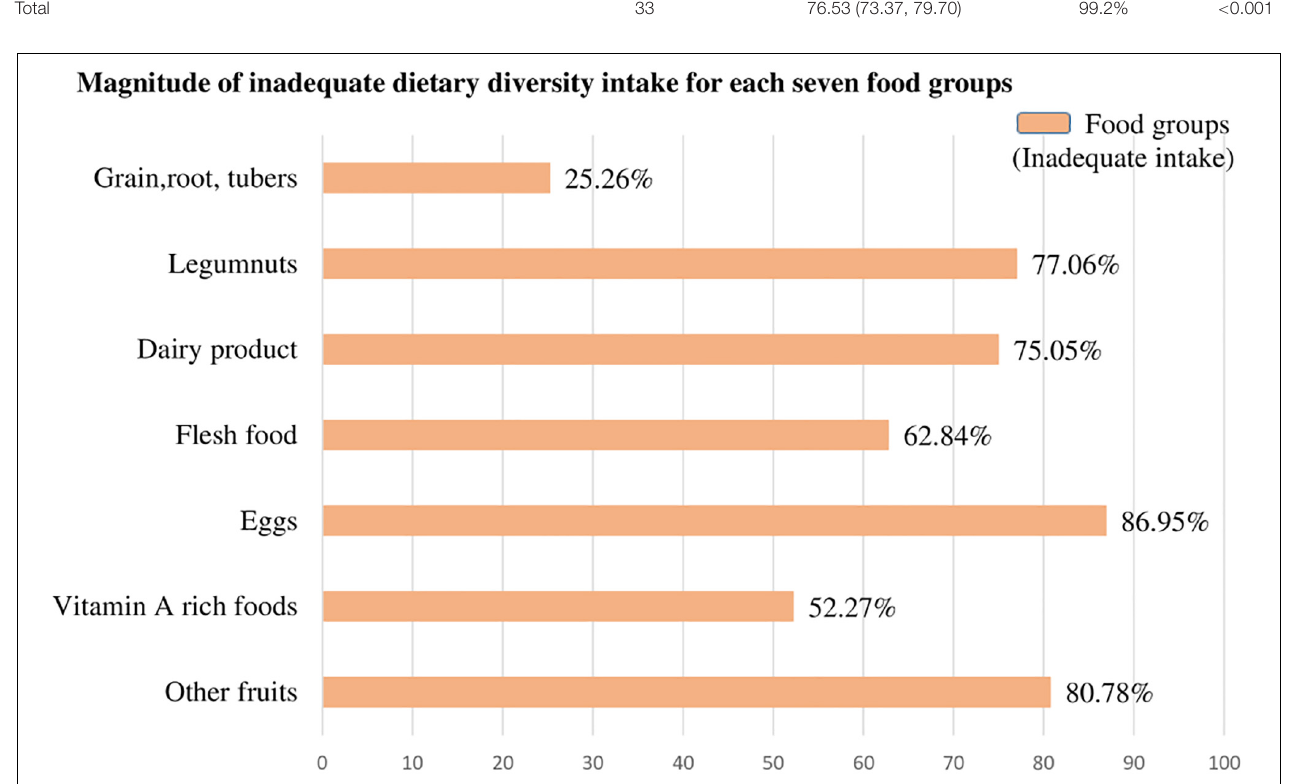
FIGURE 2 | The magnitude of inadequate dietary intake for each seven food groups among children aged 6–23 months in SSA.